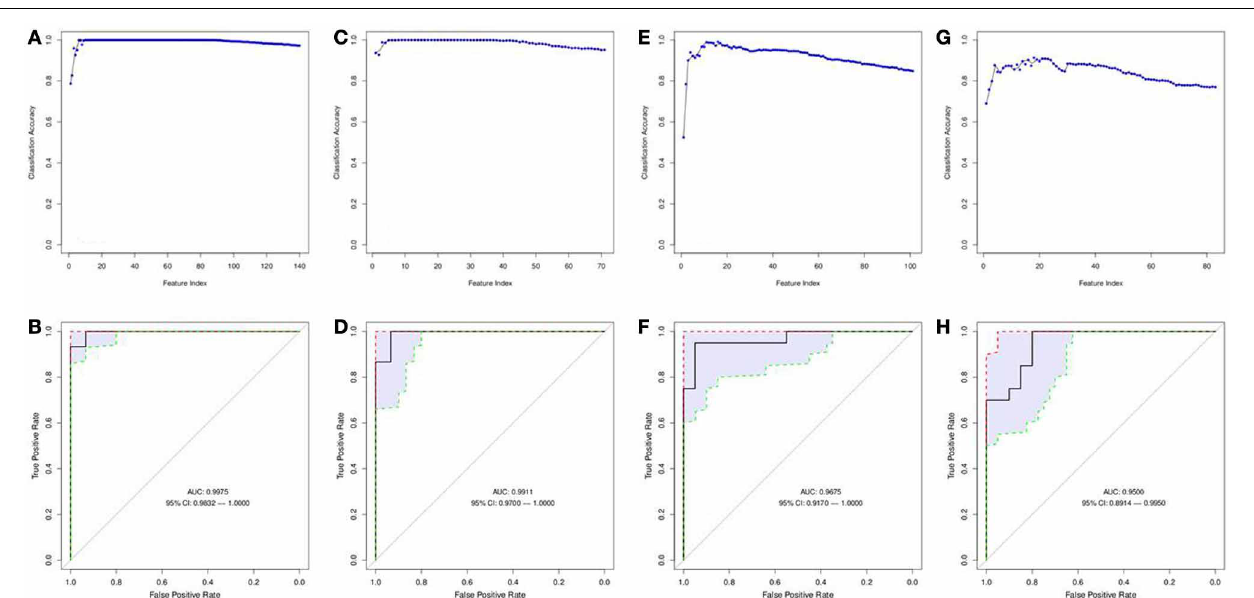
FIGURE 6 | Features selected by SVM-RFE machine learning method for biofluids based analysis. Results of feature selection for metabolomics data in biofluids samples by SVM-RFE and ROC curves with confidence intervals are shown. Minimal number of features were selected for each data type providing maximum accuracy of classification for clinical outcome. Metabolites in Serum (positive charge) SVM-RFE results (A) and